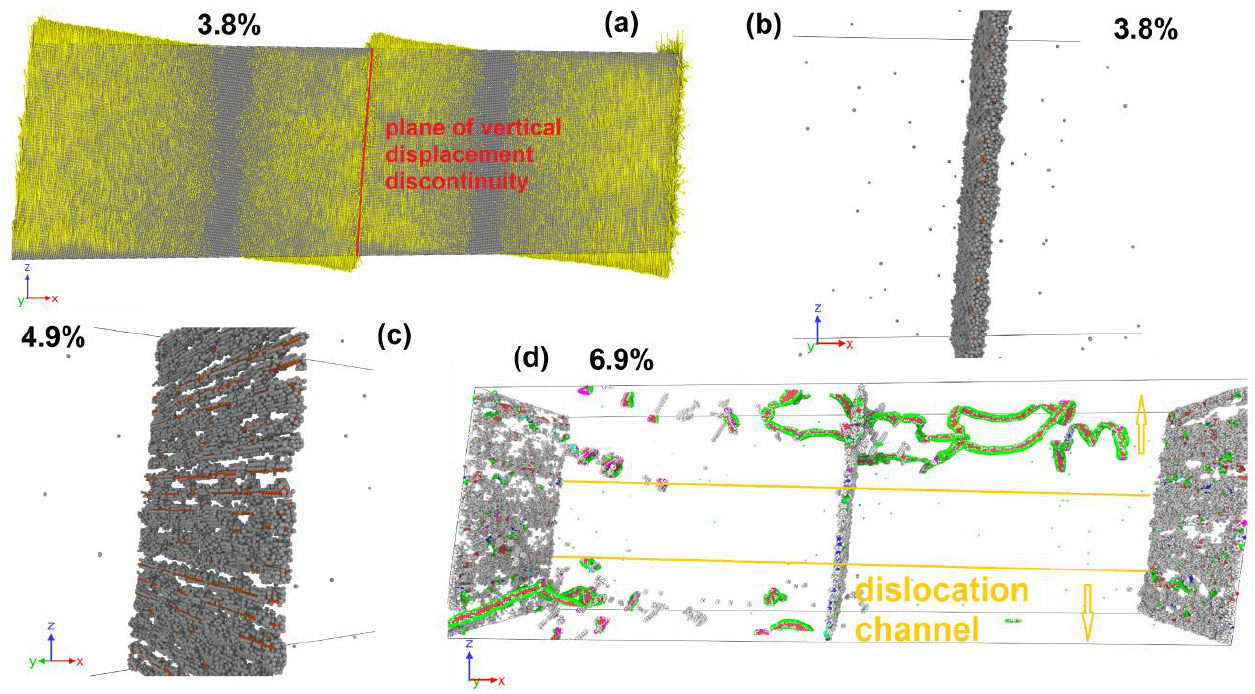
Figure 8. Deformation of system with 3.75% filling of three columns by Cu atoms (5.47 nm − 2 ). ( a ) Displacement vectors of atoms (yellow); in each grain, the vertical displacements change sign; the vertical displacements discontinuity is located at both GBs (red line). Rotation center is visible in each grain. ( b ) Disordered layer near the GB along which the grains slide. Al atoms are grey dots, Cu—orange. Only atoms with central symmetrical parameter exceeding 5 are shown. ( c ) The same GB after rotation stopped. One can see the order of atoms on the GB (gaps appear in the defect atom distribution). ( d ) Formation of dislocation channel through both grains. Only atoms with central parameter exceeding 5 are shown. Grey dots are FCC-type atoms, red—HCP. Dislocation structure is determined by DXA: blue lines are perfect dislocations, green—Shockley partials, light blue—Frank partials, purple—stair rod segments.